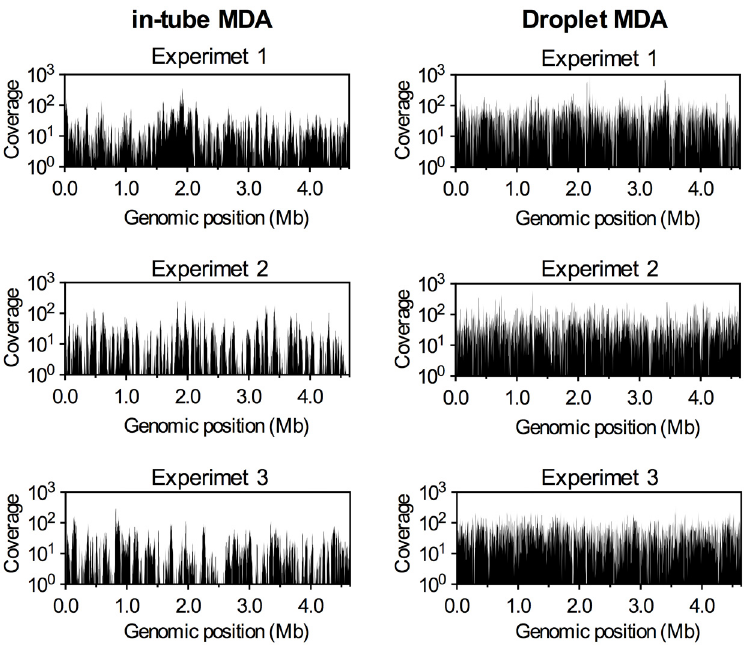
Fig 4. Evaluation of amplification bias of droplet MDA. Distributions of sequencing coverage of MDA products from single Escherichia coli cells (n = 3) were compared between in-tube MDA (left column) and droplet MDA (right column). Each graph shows the results of independent reactions. The averaged sequencing coverages were calculated from raw sequencing reads that mapped to with E . coli reference genome within 1-kb windows. Sequencing reads were normalized to 60× sequencing effort in each